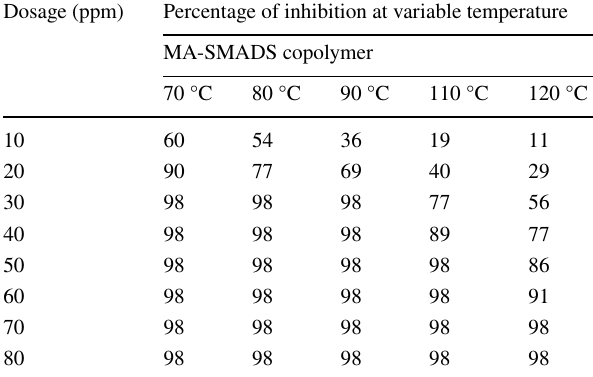
Fig. 8 Effect of temperature on polymer inhibition